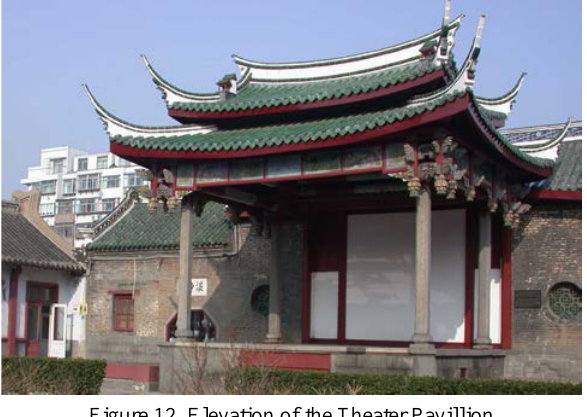
Figure 12. Elevation of the Theater Pavillion